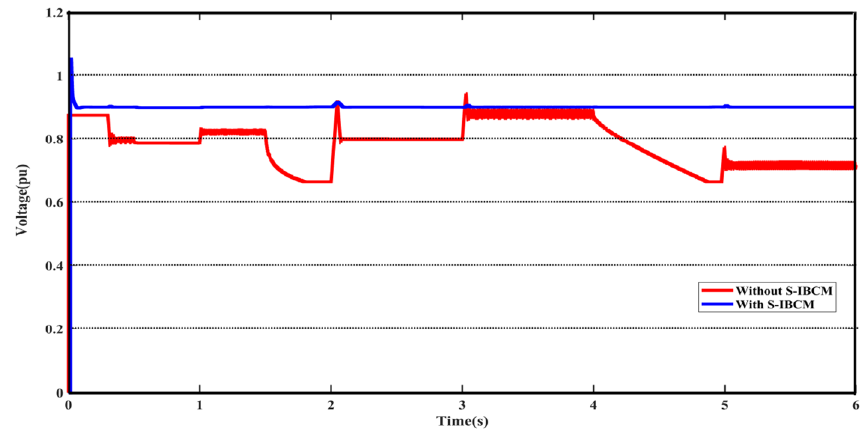
Figure 10. The DCMG terminal voltage with and without S-IBCM.